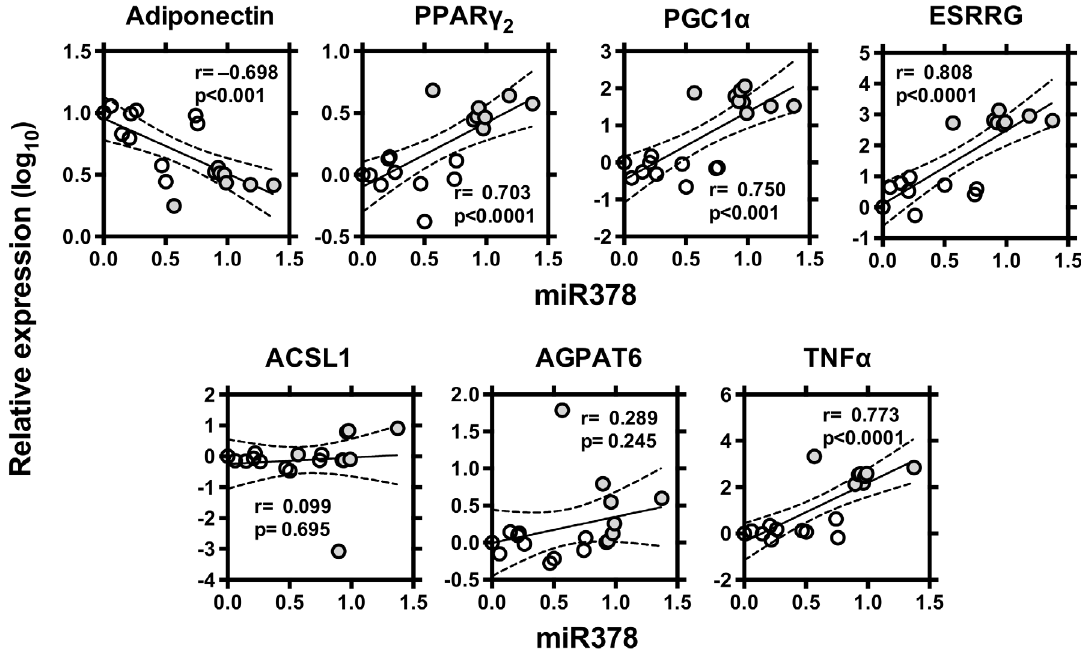
Figure 7. Correlation between level of miRNA-378 vs levels of adiponectin, PPAR c 2 , PGC1 a , ESRRG, PGC1 b , ACSL1, AGPAT6 and TNF a in the adipose tissue of C57BL/6 and ob/ob mice. From normal C57BL/6 ( = , n=10) or diabetic ob/ob ( = , n=10) mice, epididymal N adipose tissues were excised and used for gene expression analyses. Expression levels normalized to those of b -actin were log-transformed. Linear ) mice and, and r and p values are regression analysis was made on a combined group of C57BL/6 ( # ) and ob/ob (